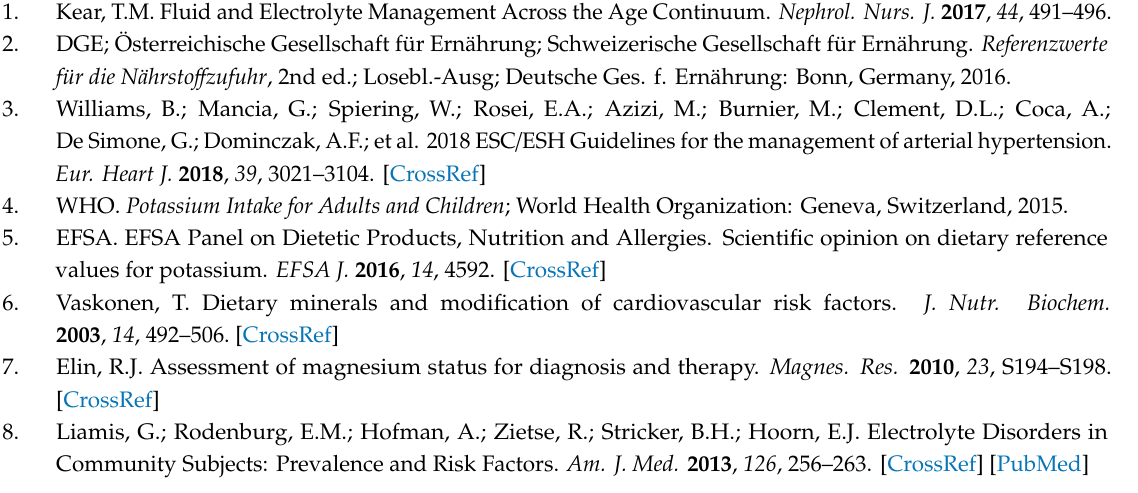
Table S1: Electrolyte intake in association with gender, age groups and dietary patterns. Data shown as mean values and standard deviation in parentheses in mg / day; Table S2. Percentage of persons with a discrepancy between reported intake and the recommended values for sodium, potassium, calcium and magnesium in di ff erent age